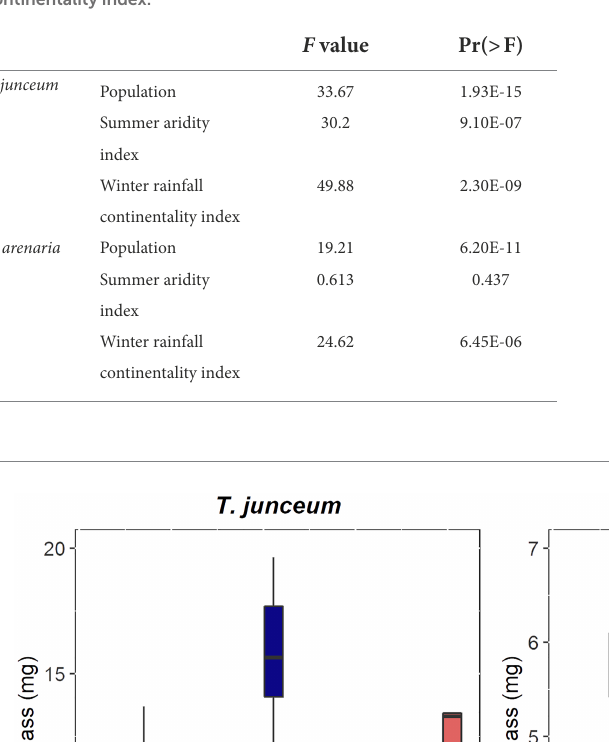
TABLE 4 F and p values of anova, comparing seed mass against the population, the summer aridity index, and the winter rainfall continentality